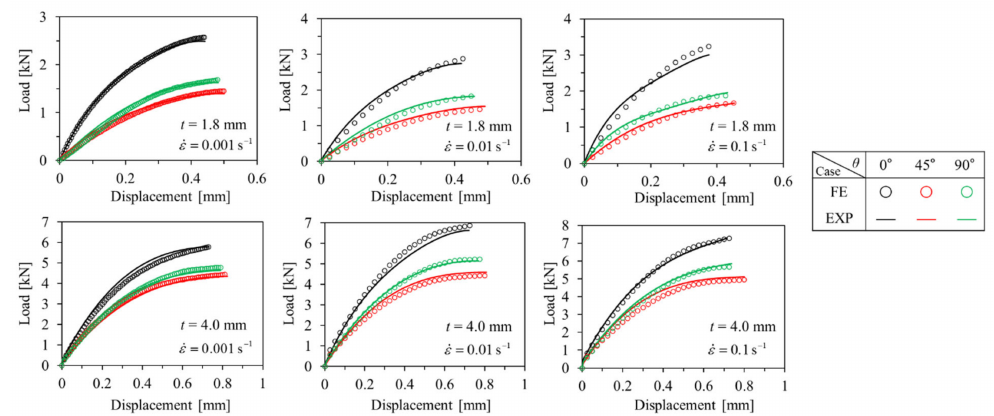
Figure 18. Comparison between experimental and numerical results for ASTM-D3410 compressive specimens. Table 1. Model constants for the Ramberg–Osgood flow stress model and for the modified Hill’48 yield function.